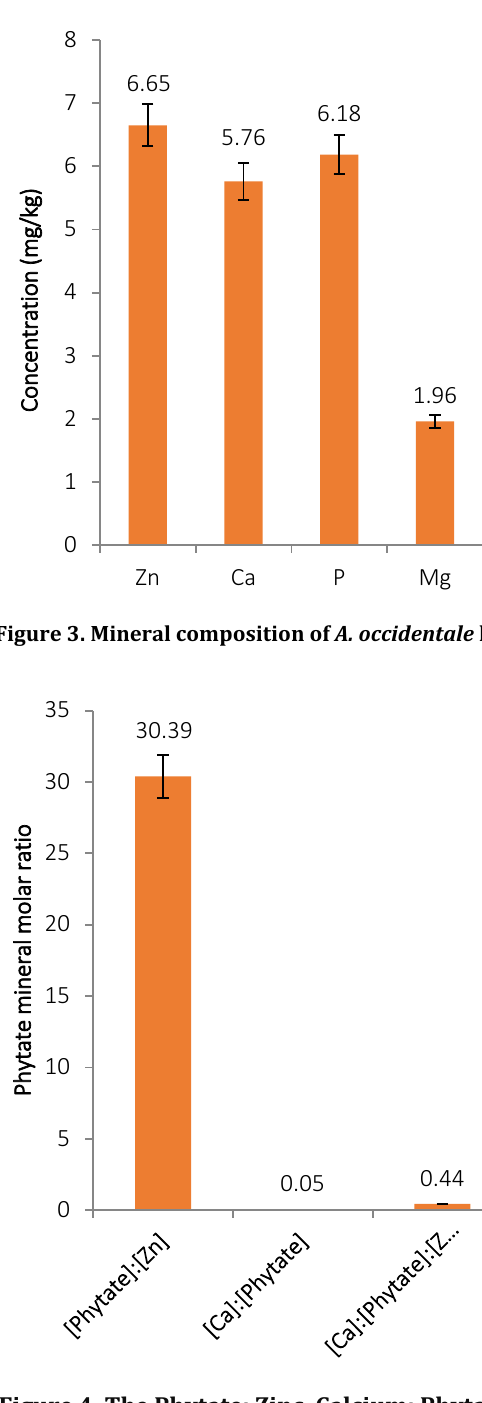
Figure 4. The Phytate: Zinc, Calcium: Phytate and [Calcium] x [Phytate]: [Zinc] molar ratios of A. occidentale leaf